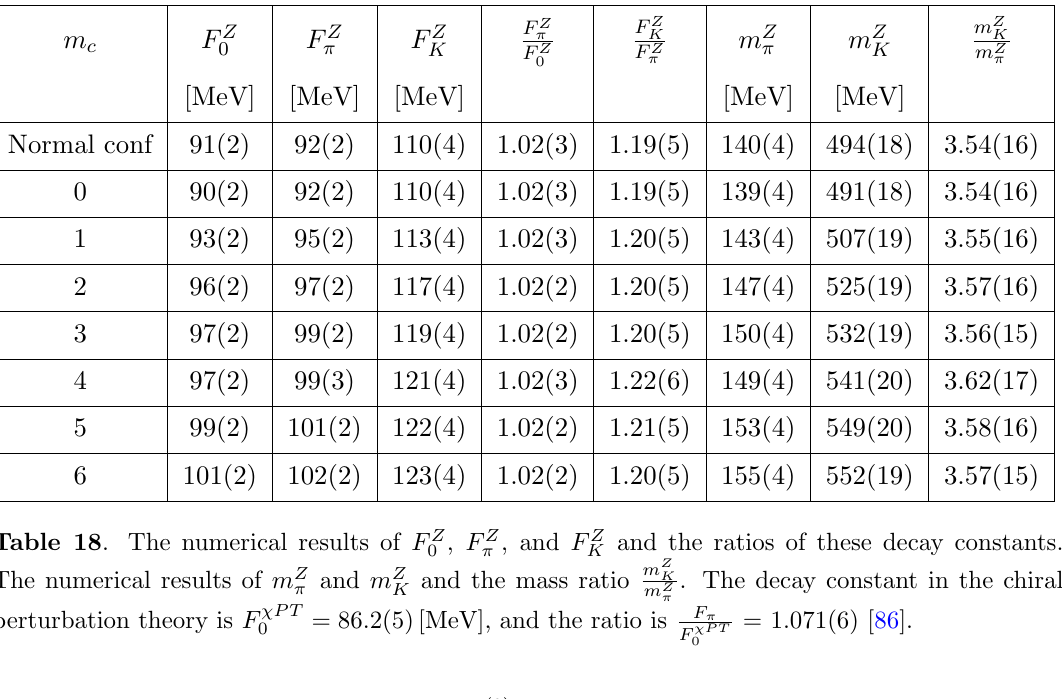
Table 18 . The numerical results of F Z The numerical results of m Z perturbation theory is F (cid:31)PT